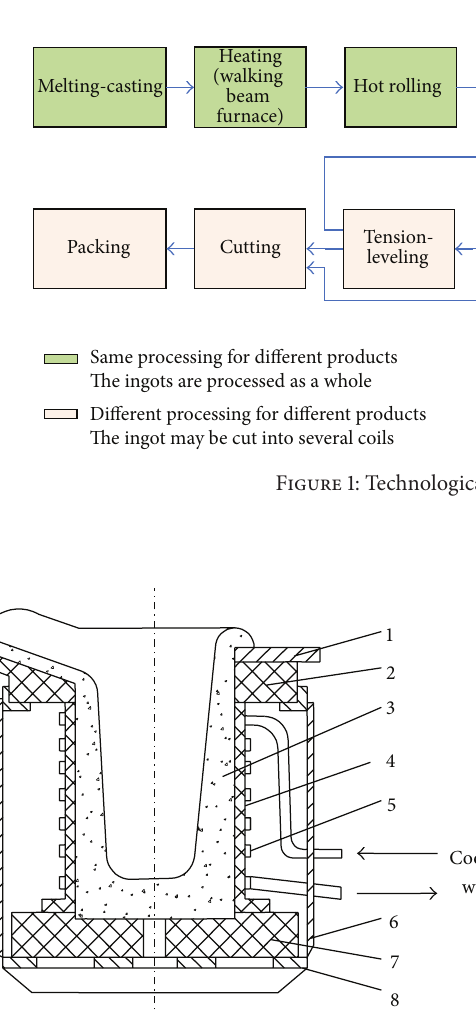
Figure 2: Schematic diagram of electric induction